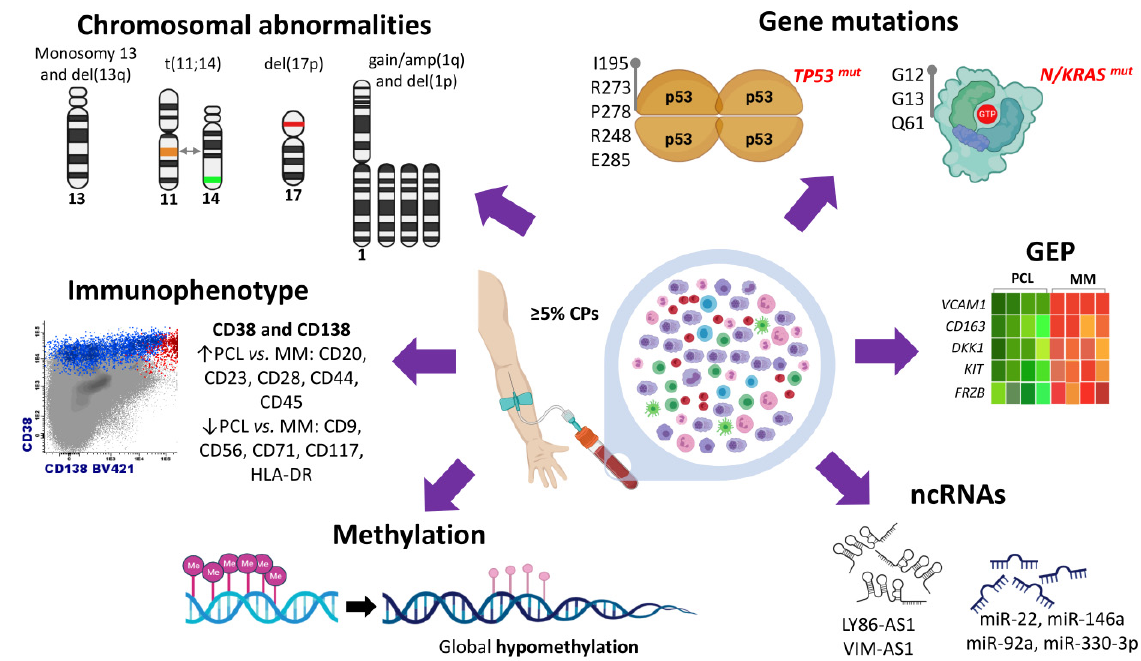
Figure 1. Genomic abnormalities of primary plasma cell leukemia (pPCL). The updated consensus of the IMWG defines pPCL by the presence of 5% or more circulating plasma cells in peripheral blood. Cytogenetic studies by FISH show predominance of monosomy and deletions of chromosome 13, t(11;14), del(17p), gain/amp(1q) and del(1p). Mutation studies by conventional DNA sequencing, WES, and targeted NGS detect a high frequency of mutations in TP53 and K/NRAS genes. The amino acids most frequently mutated in TP53 are I195, R273, P278, R248, and E285. Activating mutations of K/NRAS most frequently found in pPCL patients affect codons 12, 13, and 61 (G12, G13, and Q61). Immunophenotyping of plasma cells reveals expression of CD38 and CD138 in both pPCL and MM, although higher expression of CD20, CD23, CD28, CD44, and CD45 and lower expression of CD9, CD56, CD71, CD117, and HLA-DR may be found in pPCL compared to MM. Gene expression profiling in pPCL has shown downregulation of genes associated with bone marrow microenvironment and bone diseases in MM, such as DKK1 , KIT , and NCAM1 genes. A global hypomethylation profile has been found in pPCL samples. Non-coding RNAs (miRNAs and lncRNAs) are dysregulated in pPCL, and some of them are associated with survival of patients (as shown in the figure).